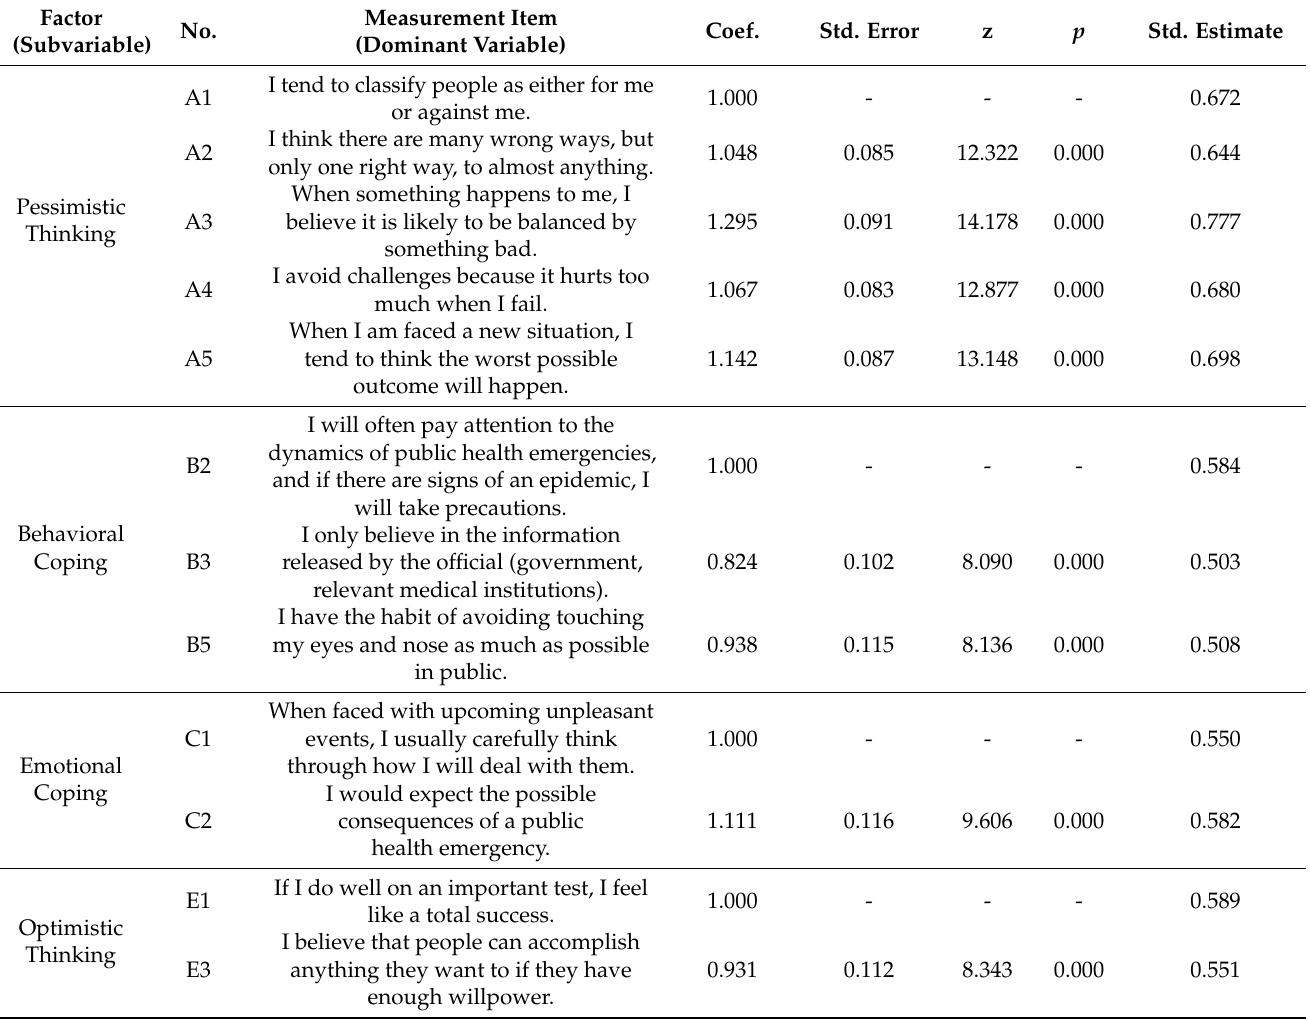
Table 9. Table of factor loading coefficient.